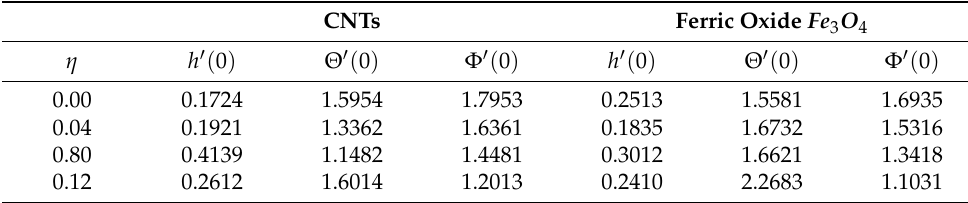
Table 5. Quantitive analysis for the Nusselt number and the Skin